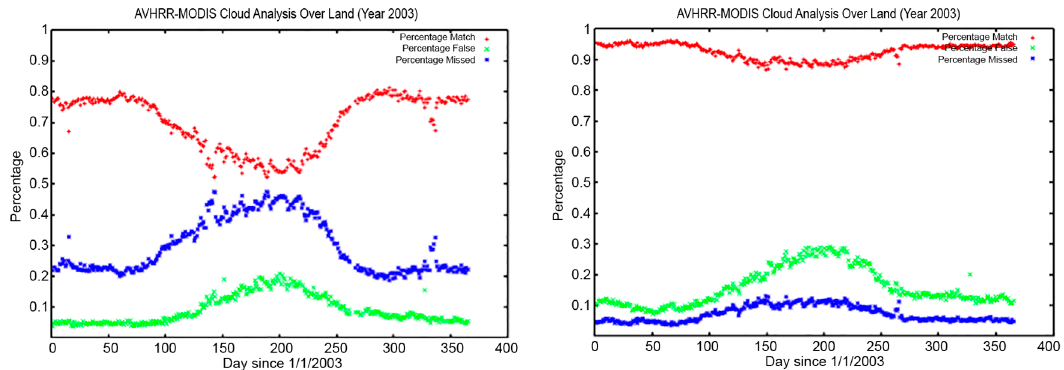
Figure 4. Evaluation of the global performance of the current cloud mask for NOAA16-AVHRR versus the MODIS Aqua cloud mask. Results are reported as percentages. The left side is the CLAVR algorithm [14]. The right side is the current LCDR improved cloud mask. The MODIS Aqua cloud mask is used as truth in this comparison. Red symbols (match) show the percentage of agreement between AVHRR and MODIS, Green symbols (false) show the percentage of cases where AVHRR erroneously detects clouds. Blue symbols (missed) show the percentage of cases where AVHRR missed clouds.